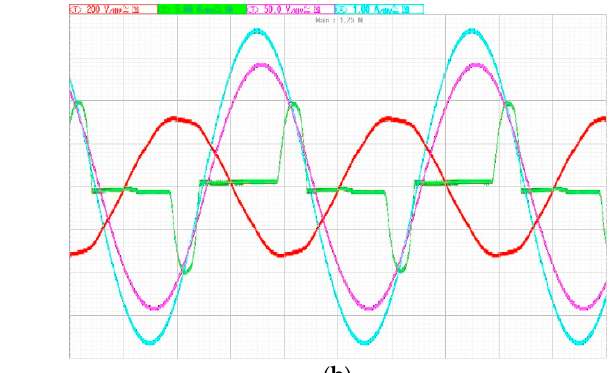
Figure 13. Measuring circuit used to determine the values of voltage gain error and phase shift.